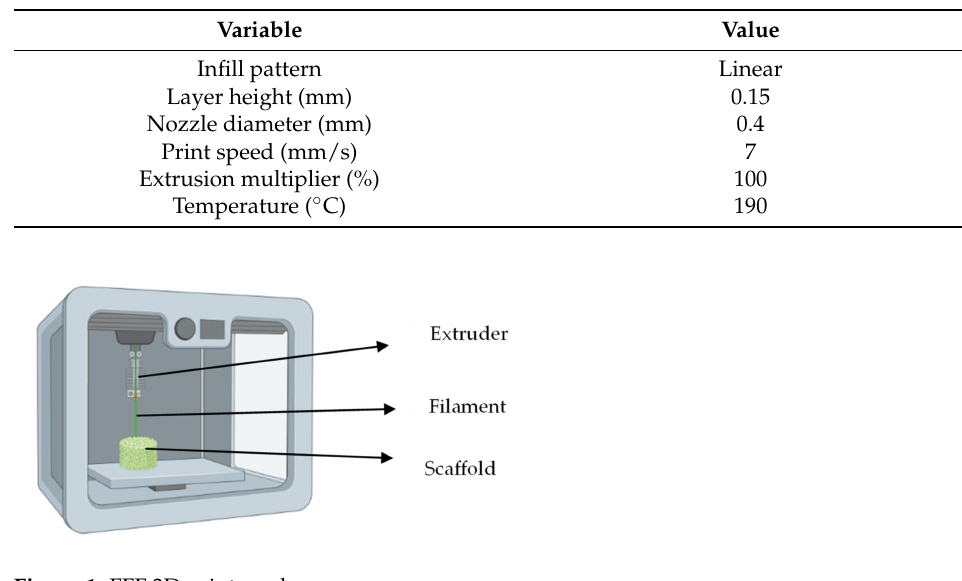
Figure 1. FFF 3D printer